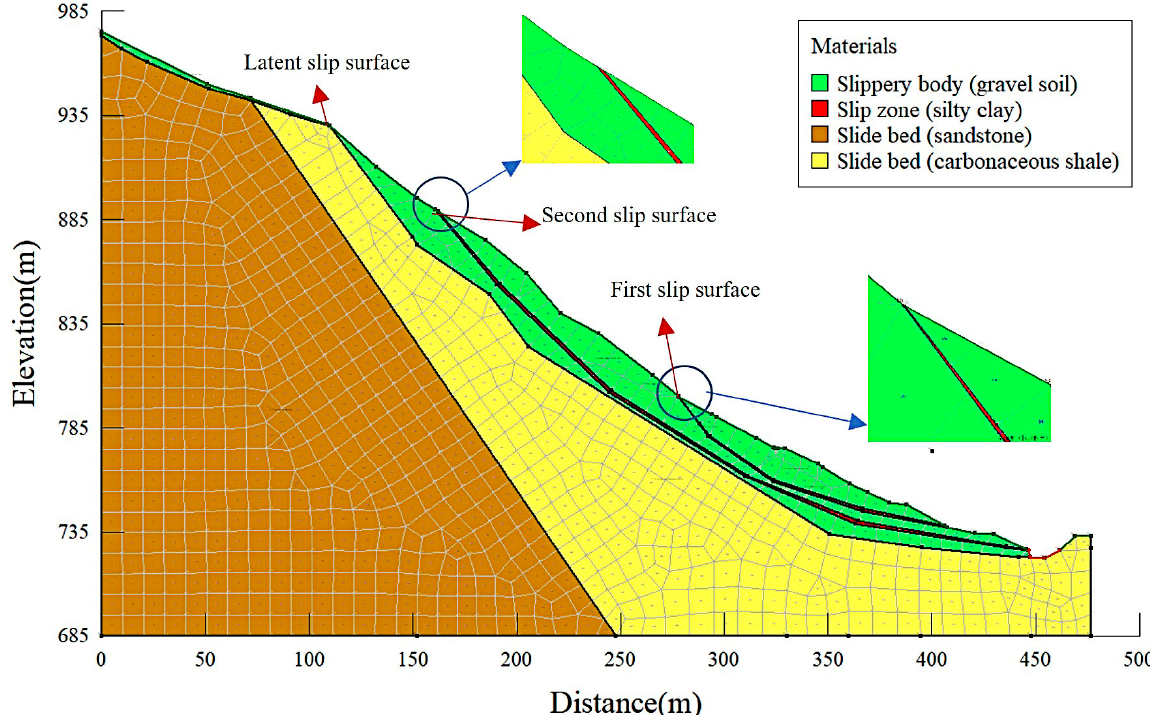
Figure 10. Grid model of two landslide events of the 2-2 profile.